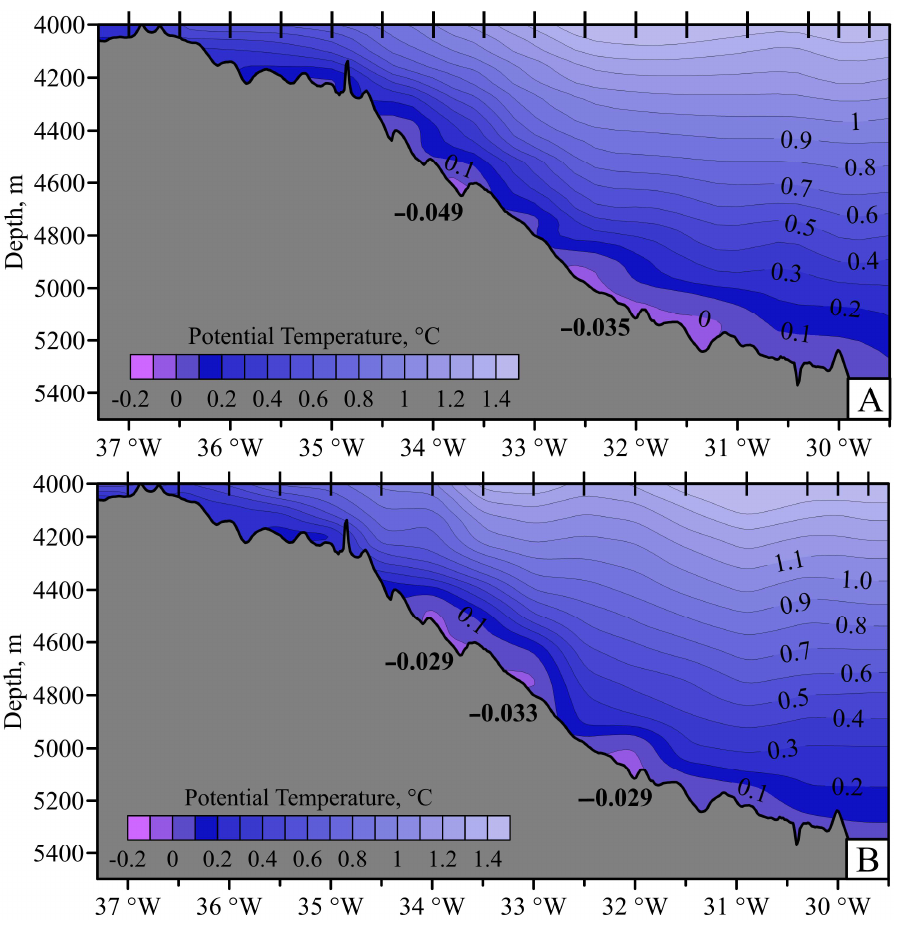
Figure 5. Sections of potential temperatures deeper than 4000 m in 2009 ( A ) and 2018 ( B ) (WOCE line A09 along 24° S). The coldest bottom potential temperatures are indicated over the background of the bottom.